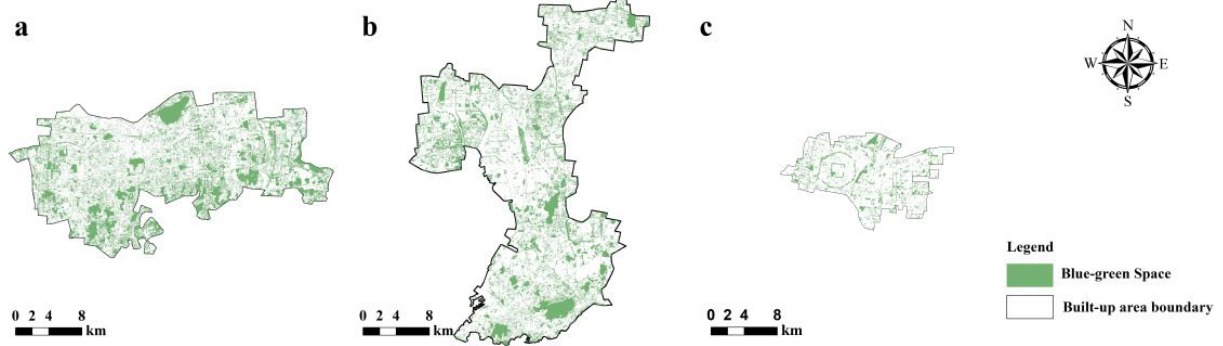
Figure 3. Blue – green spatial distribution in (a) Jinan, (b) Qingdao, and (c) Heze.